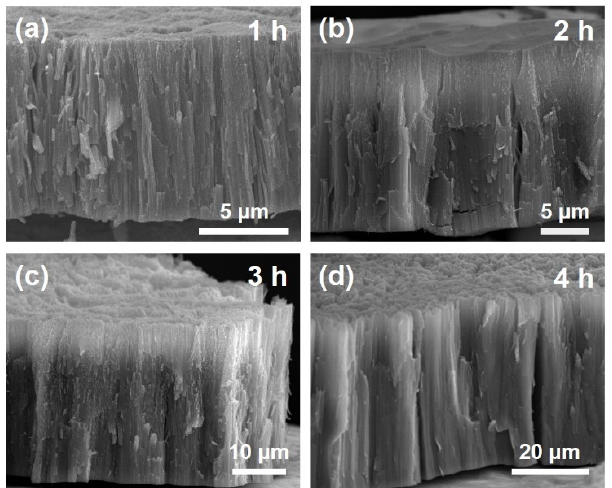
Figure 2. ( a – d ) Side-view of FE-SEM images of the annealed anodic TiO 2 NT electrodes prepared by anodization for 1–4 h.